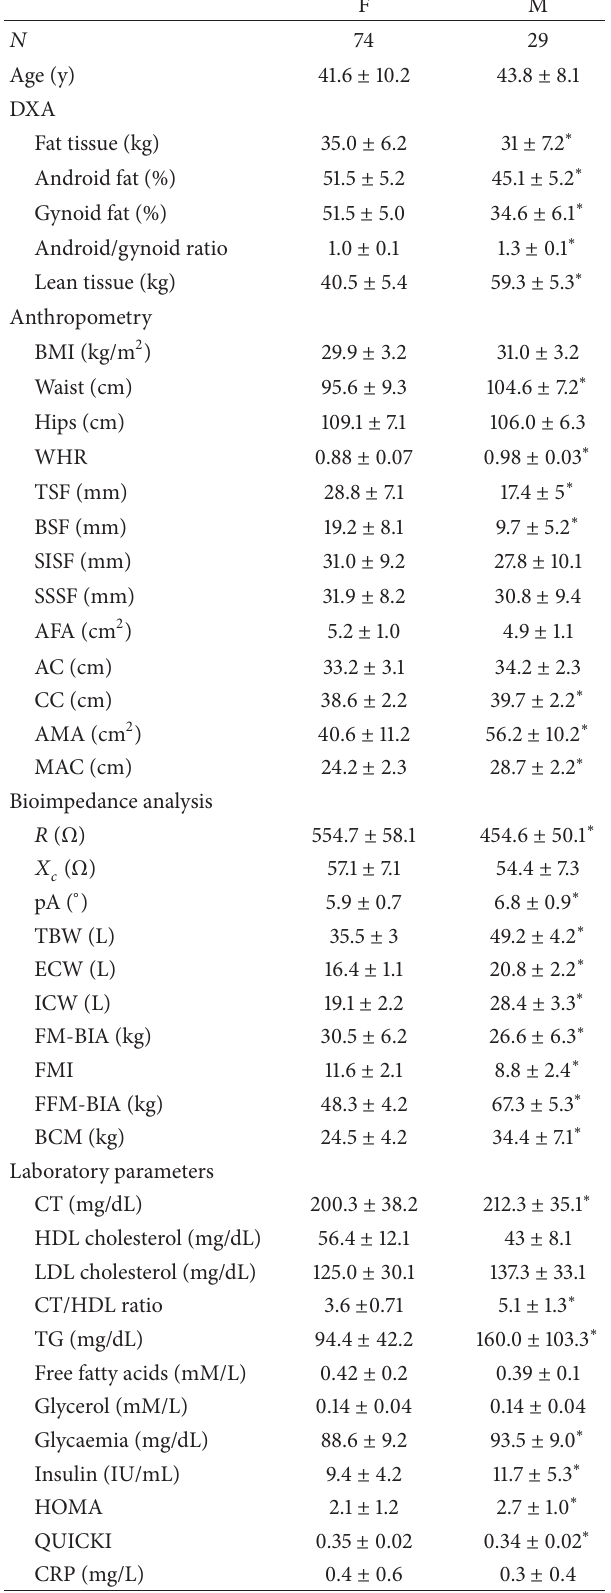
Table 1: Body composition and biochemical parameters of subjects studied 1 .